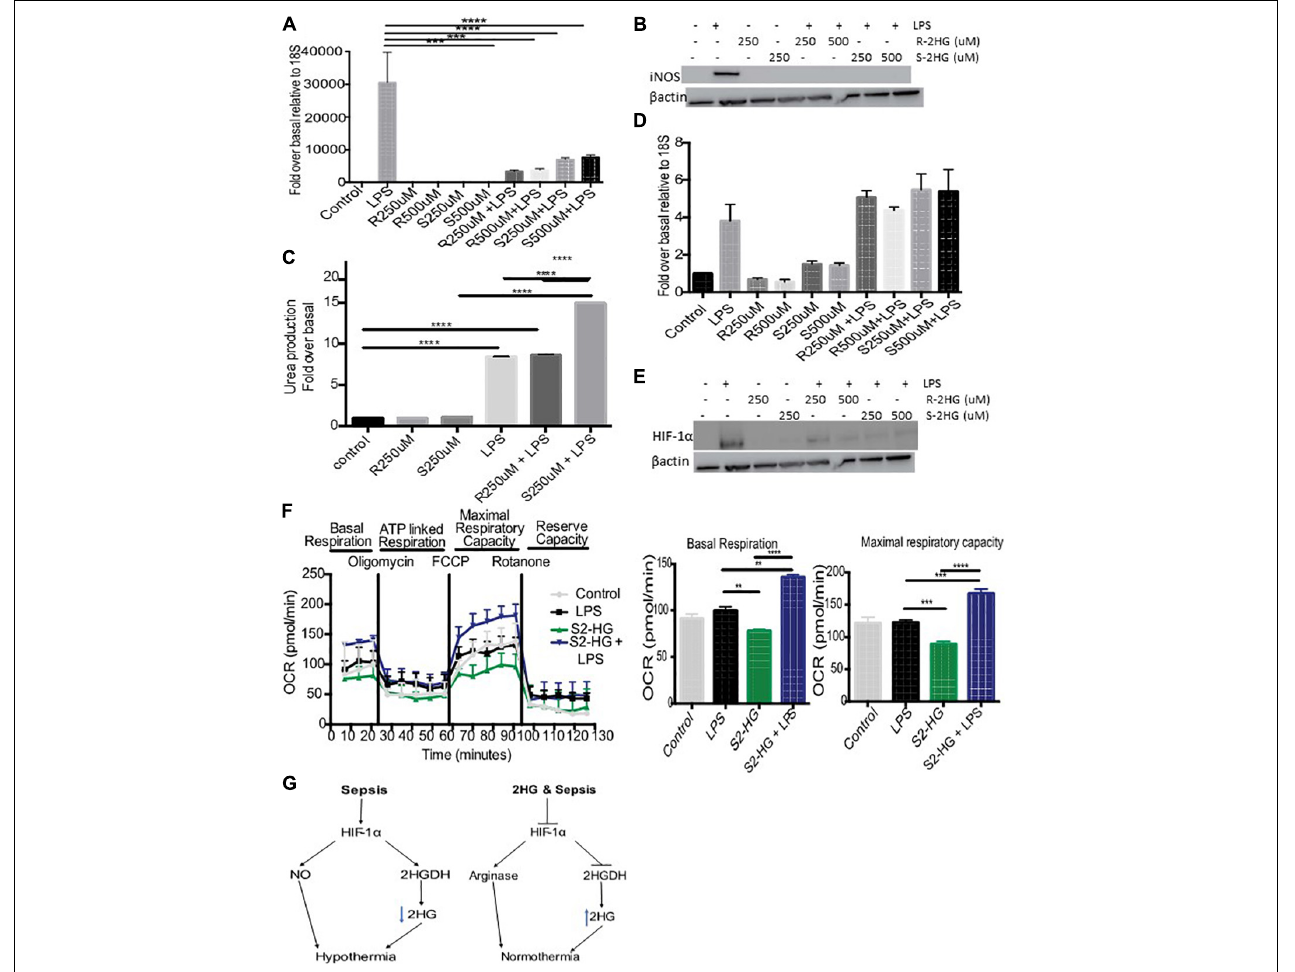
FIGURE 3 | 2HG protects against LPS driven HIF-1 α stabilization. BMDB were treated with 250 or 500 uM R-/S-2HG in the presence or absence of LPS. 24 h post-stimulation (A) iNOS RNA expression was quantified by RT-PCR, (B) iNOS protein expression was determined by immunoblotting (C) Arginase activity was measured using a urea production assay. (D) HIF-1 α mRNA was measured by RT-PCR (E) HIF-1 α protein expression was measure by western blot analysis (F) BMDM were treat with LPS for 4 h and a Seahorse Mitochondrial Stress Test was carried out. N = 3–5 for all experiments. * p < 0.05, *** p < 0.005, **** p < 0.001. (G) Schematic of the role of 2HG in endotoxemia induced